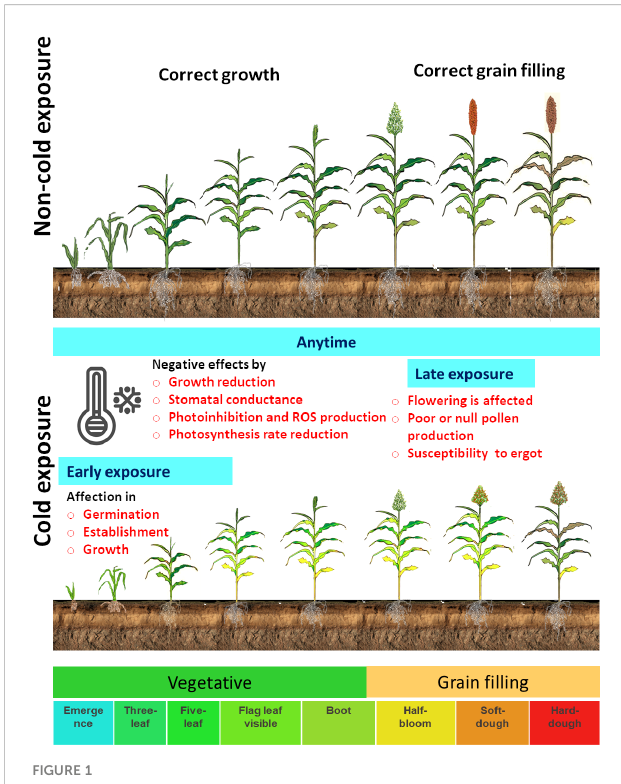
FIGURE 1 Diagrammatic illustration of sorghum development and the cold exposure effect in sorghum. The principal growth stages are used to represent the effect in early, late, or any time of exposure to cold (Ostmeyer et al.,